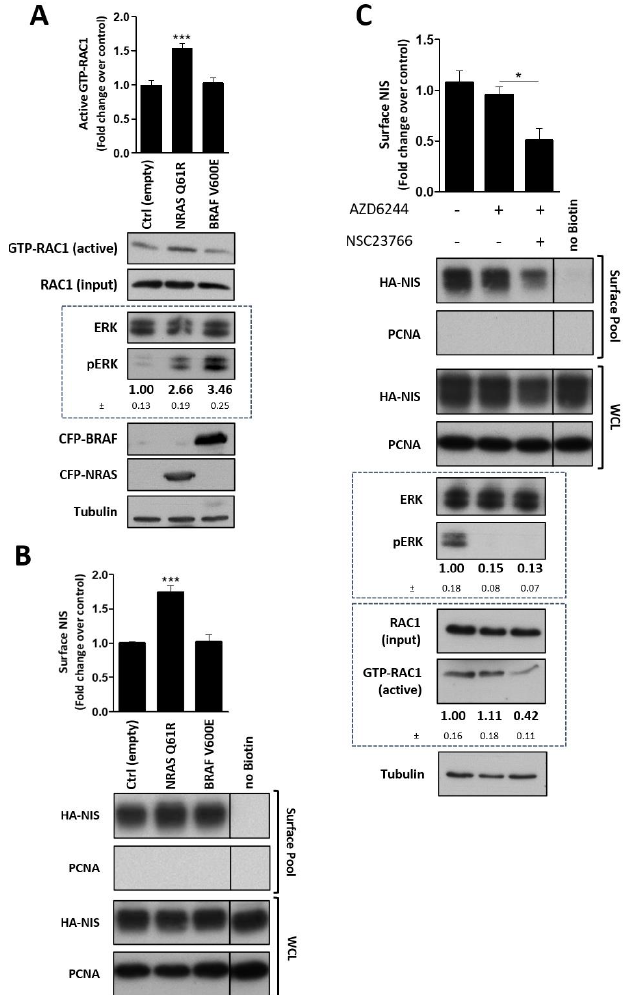
Figure 6. Impact of MEK and RAC1 signaling in NIS post-translational expression. The PTC-derived TPC1 cell line was modified to stably express full-length NIS construct containing a triple HA tag. ( A , B ) HA-NIS-TPC1 cells were transfected with CFP-empty vector [Ctrl (empty)], CFP-NRAS Q61R or CFP-BRAF V600E expressing constructs. ( A ) The activation status of endogenous RAC1 was monitored using a CRIB domain pull-down assay. Total (input) and active RAC1 levels were assessed using anti-RAC1 primary antibody. Tubulin was used as loading control. The ectopic expression of NRAS and BRAF variants was monitored in the WCL, using anti-GFP primary antibody. MAPK activation status was assessed by monitoring phosphorylated ERK 1/2 vs. total ERK 1/2 levels by western blot [quantified below the respective panel (means ± SEM of three independent assays)], using anti-phospho ERK 1/2 and anti-ERK 1/2 primary antibodies, respectively. ( B ) Cell surface proteins were biotinylated and both whole-cell lysates (WCL) and surface protein fraction were analyzed by western blot. ‘no Biotin’ condition, corresponding to cells that were not incubated with biotin, was used as control for the capture of non-biotinylated proteins. Total and surface HA-NIS protein levels were detected using anti-HA primary antibody. PCNA expression served as loading (WCL) and negative control (Surface pool). ( C ) HA-NIS-TPC1 cells were treated with AZD6244 (10 µ M for 1 h) in the presence or absence of the RAC1 inhibitor, NSC23766 (100 µ M for 1 h) and analyzed as in ( A , B ). Then, in all panels, WB bands were quantified by densitometry analysis using ImageJ software (NIH, Bethesda, MD, USA; see Figure S3 for uncropped WB). Plotted values are means ± SEM of five independent assays. One-way ANOVA analysis detected significant differences between conditions [( A ) F = 17.36, p < 0.001; ( B ) F = 29.50; p < 0.001; ( C ) F = 5.33, p = 0.034]. Post-hoc Tukeys’s tests were used to identify significant variations relative to control conditions (* p ≤ 0.05; *** p ≤